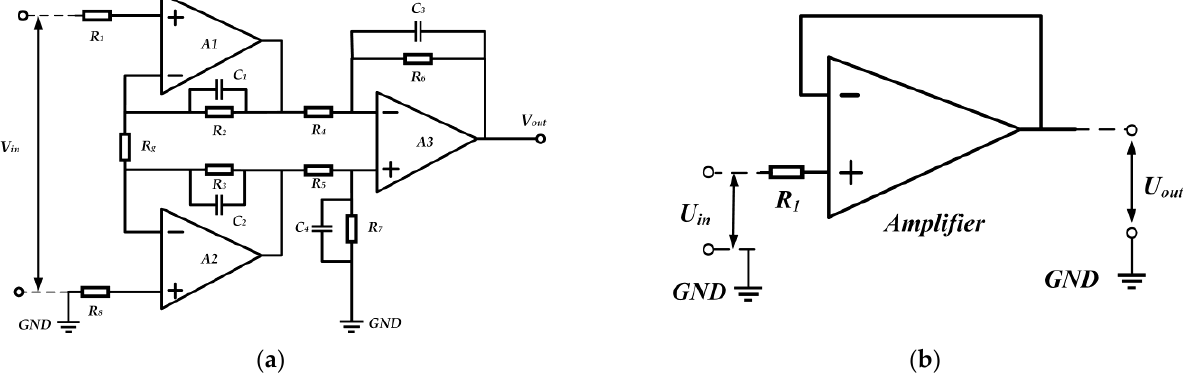
Figure 4. Schematic diagram of signal conditioning circuit. ( a ) The new circuit; ( b ) the old circuit.